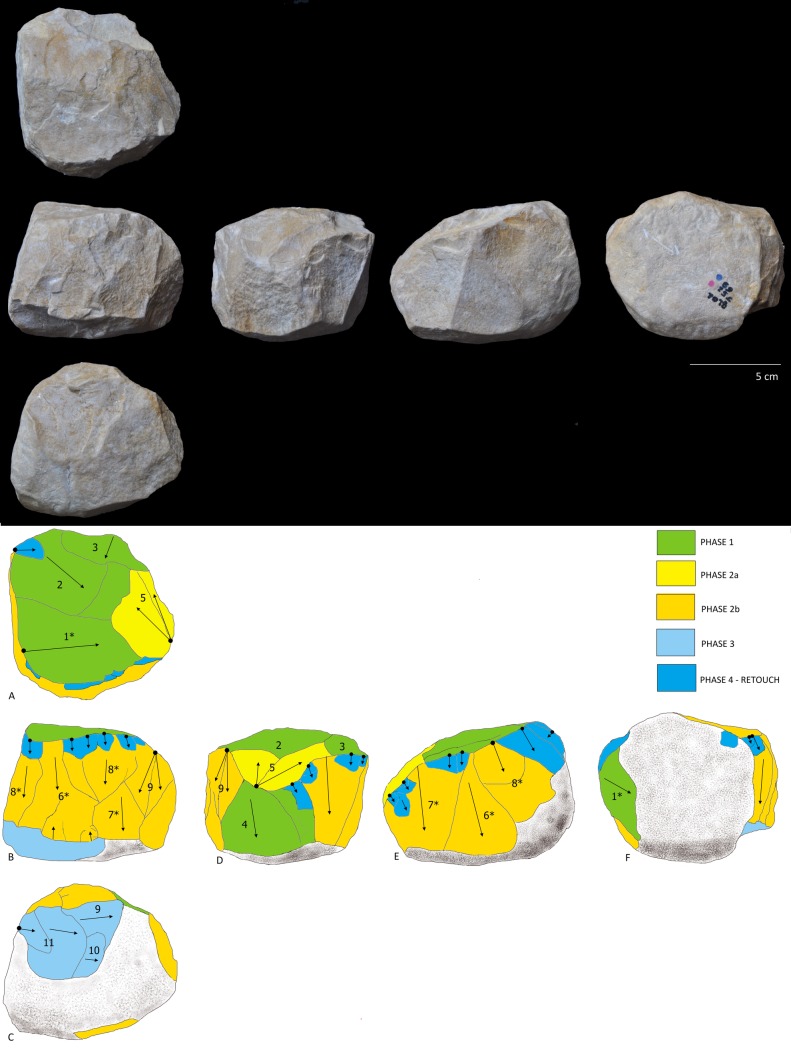
Photo and diacritical drawing of Tool F.Phase 1 (green): Peripheral removals (Profiles D) and creation of the main knapping platform (Profile A). Phase 2a (light yellow): a Siret flake (negative 5, Profiles A and D) was obtained obliquely, creating a contact area separating the two surfaces defined in Phase 1. Phase 2b (dark yellow): a new series of parallel, peripheral removals was made, departing from the platforms defined in Phases 1 and 2a (Profiles B and E) (between them Phase 1 and Phase 2a). Phase 3 (light blue): the cobble was rotated to knap a few flakes that cut into the surface of the Phase 2b negatives. Phase 4 (dark blue): retouching from the Phase 1 platform overlaps the Phase 2b negatives.